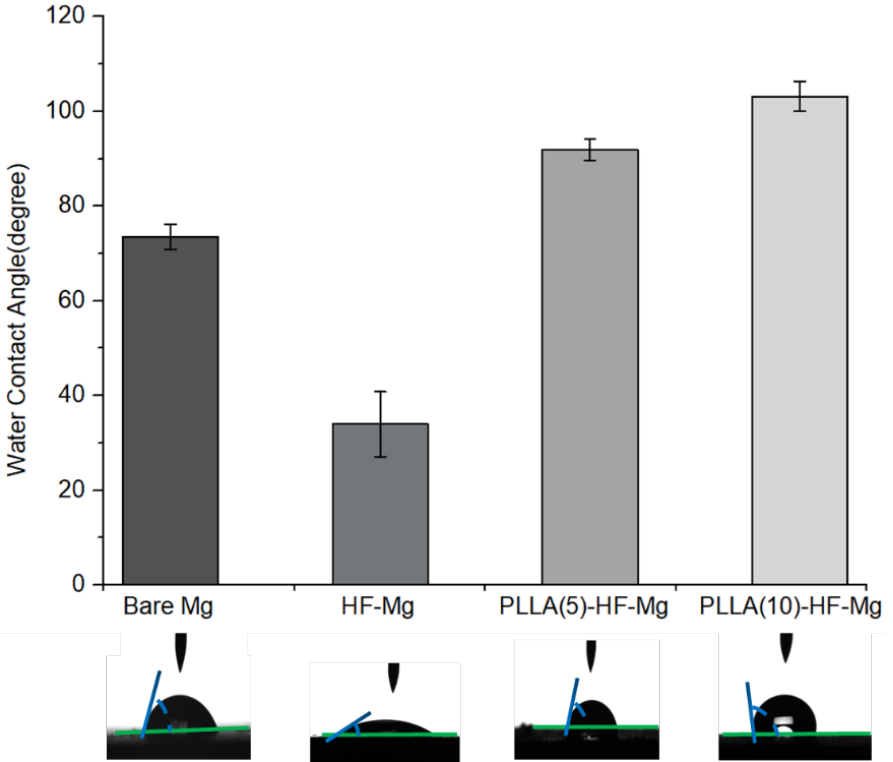
Figure 6. Water contact angle of coated and bare Mg alloys. Values are mean ± standard deviation ( n = 3).